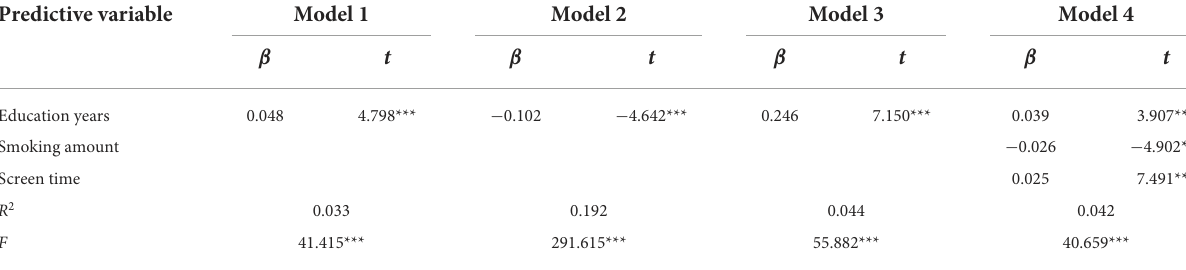
TABLE 3 Regression analysis results of smoking amount, screen time, and education years on BMI of older adults. Predictive